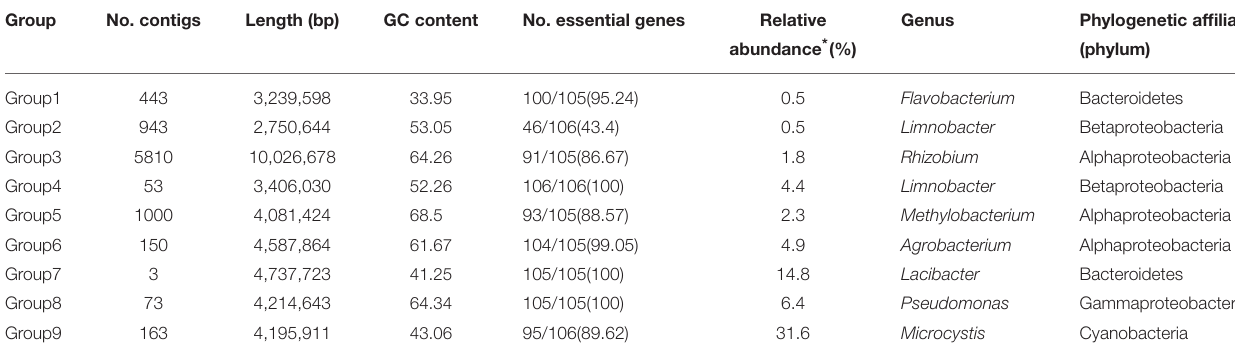
TABLE 1 | The basic statistics for each group of Microcystis colonies.